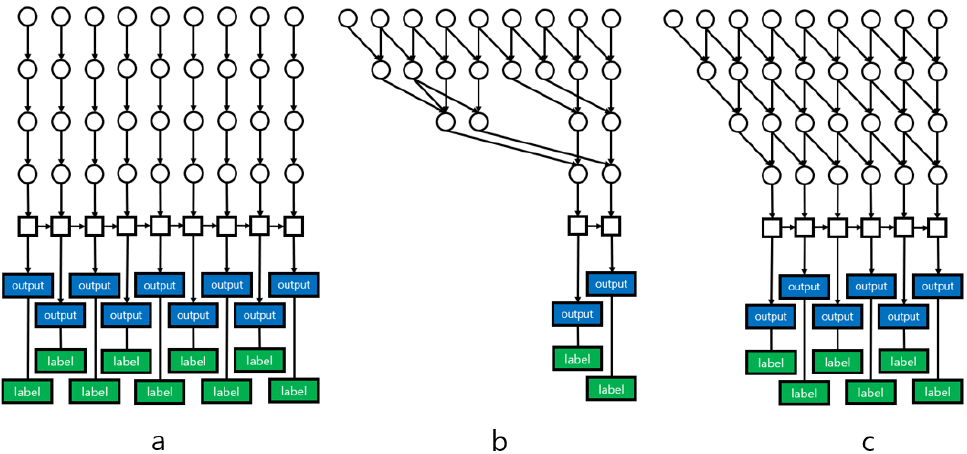
Figure 15. Learning methods: ( a ) LRCN, ( b ) TCN + LRCN, ( c ) SCCLRN.